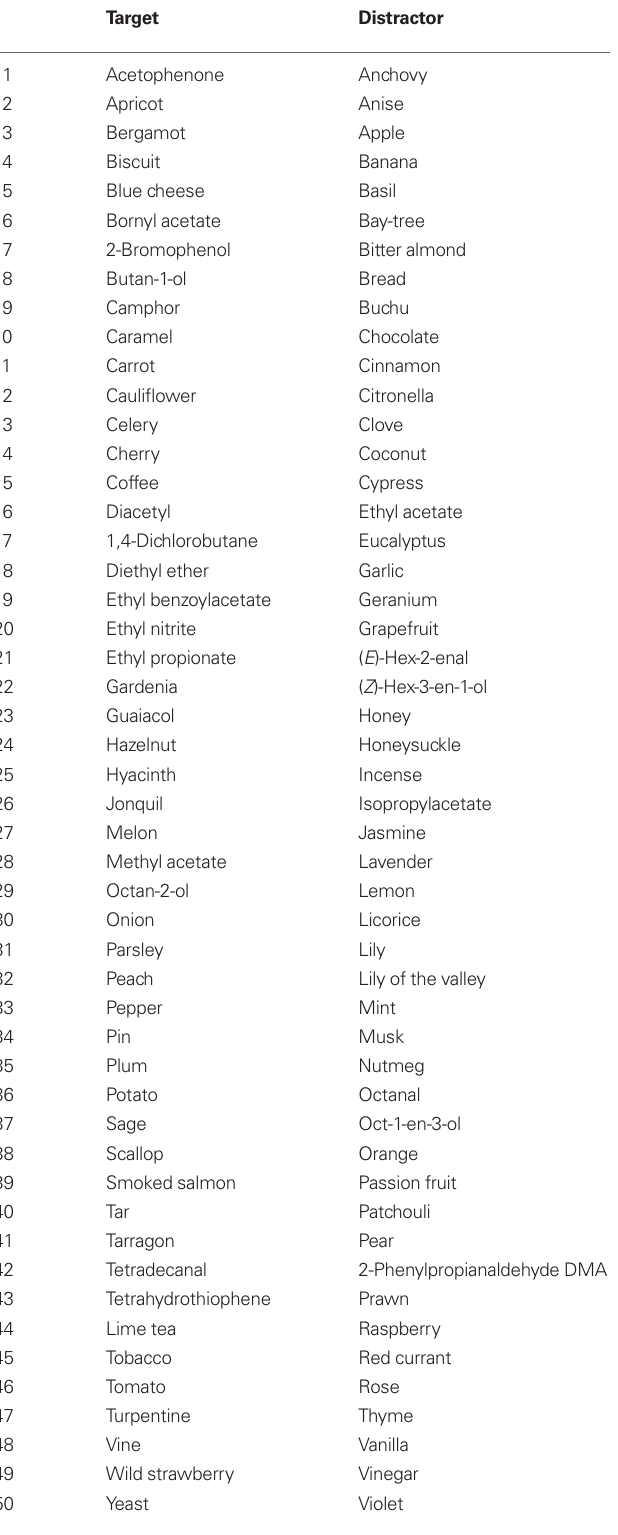
Table 1 | List of target and distractor odorants.